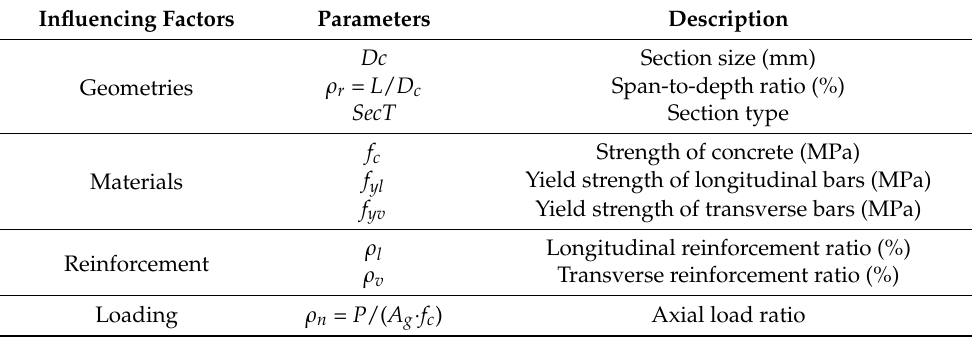
Table 2. Input parameters for LSSVM training.